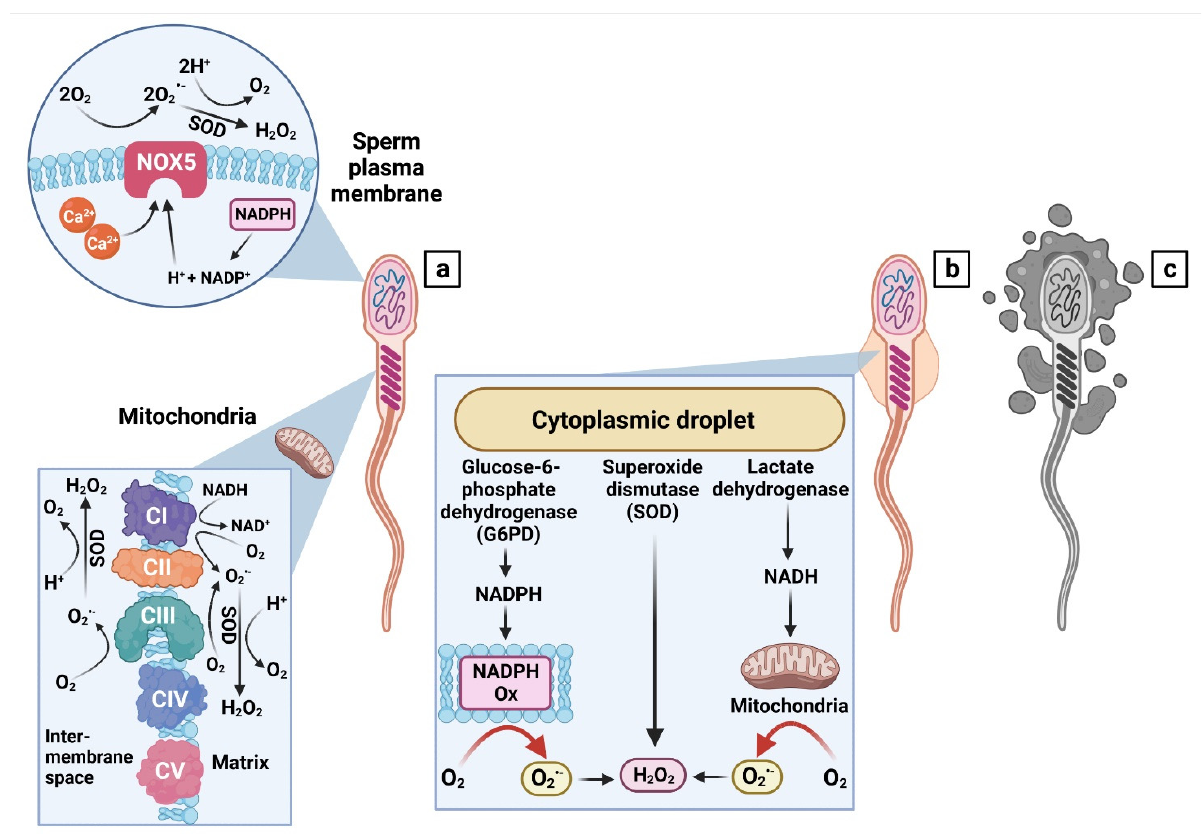
Figure 1. Sources of ROS in normal ( a ), immature ( b ) or dead ( c ) spermatozoa.